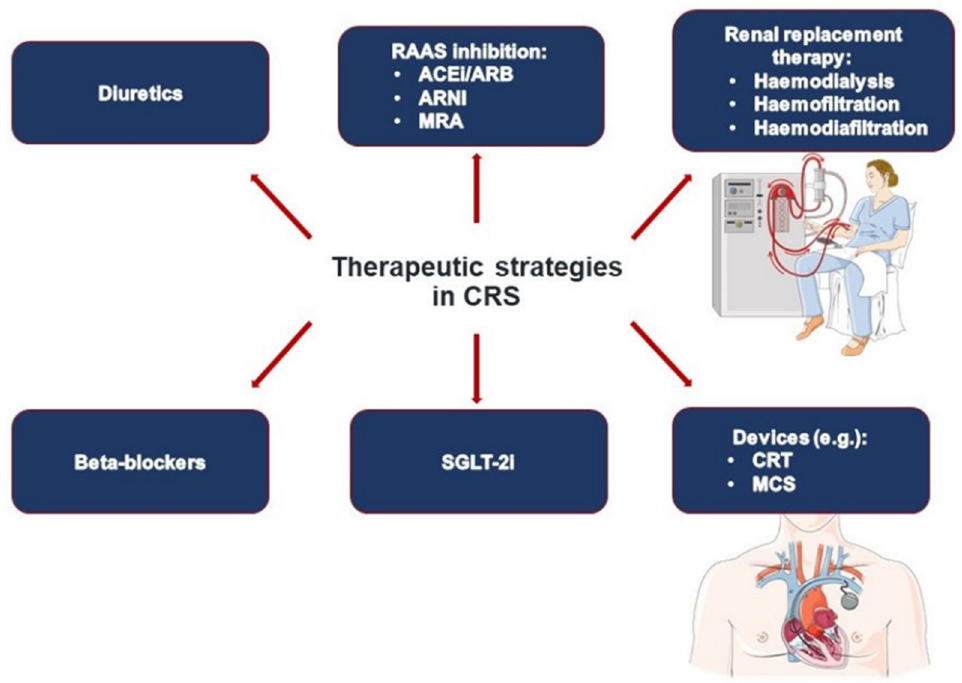
Figure 2. Therapeutic strategies in